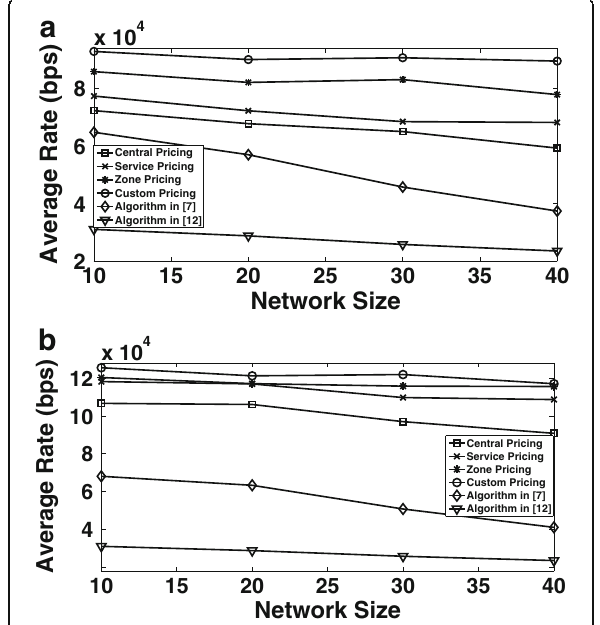
Fig. 3 Average uplink transmission data rate versus the number of users requesting a inelastic and b elastic services considering the RP framework and comparative scenarios